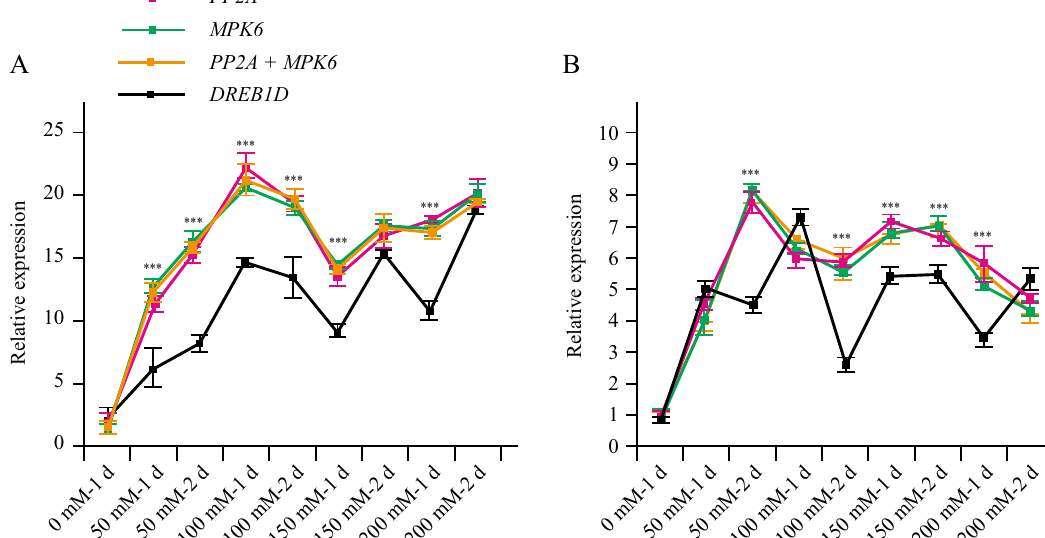
Figure 5. Relative expression levels of MYB ( A ), and AP2 ( B ), normalized by different candidate reference genes, including the most or the least stable reference genes. The asterisks indicate significant differences from DREB1D using Student’s t test (P <